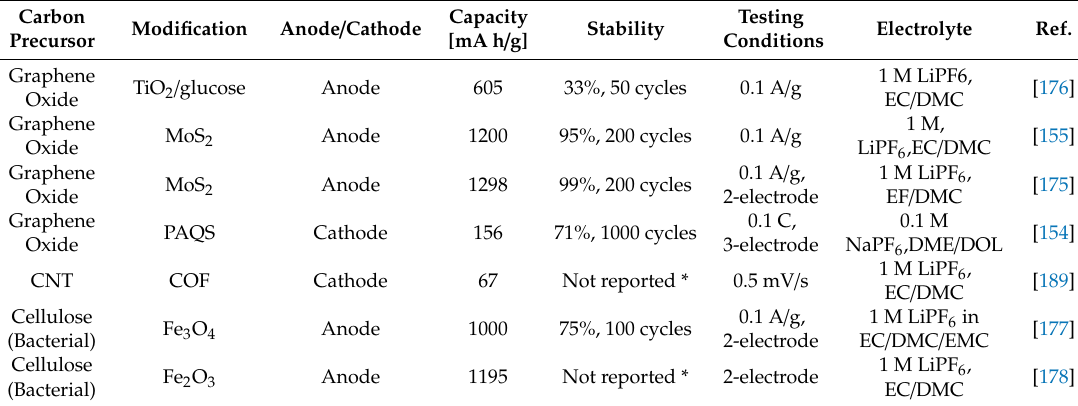
Table 3. Comparison of select carbon aerogel electrodes for lithium-ion